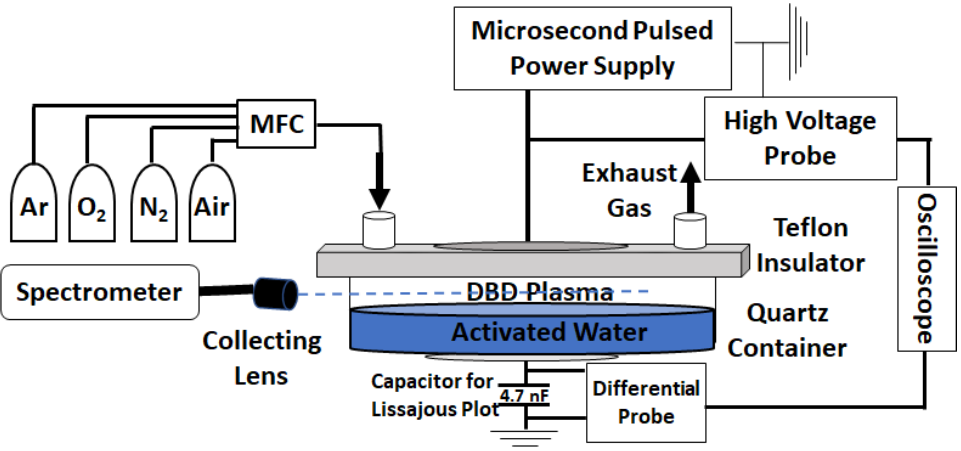
Figure 1. Schematic of the experimental setup of DBDs over water surface for plasma-activated water. The gases are injected individually via MFC .